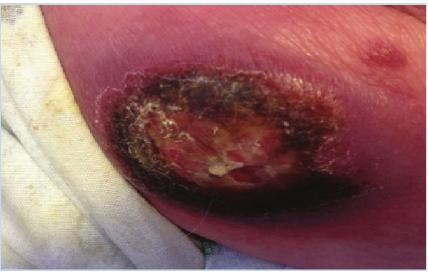
Figure 4: Ulcerated, necrotic, exudative nodule found on patient’s R lateral